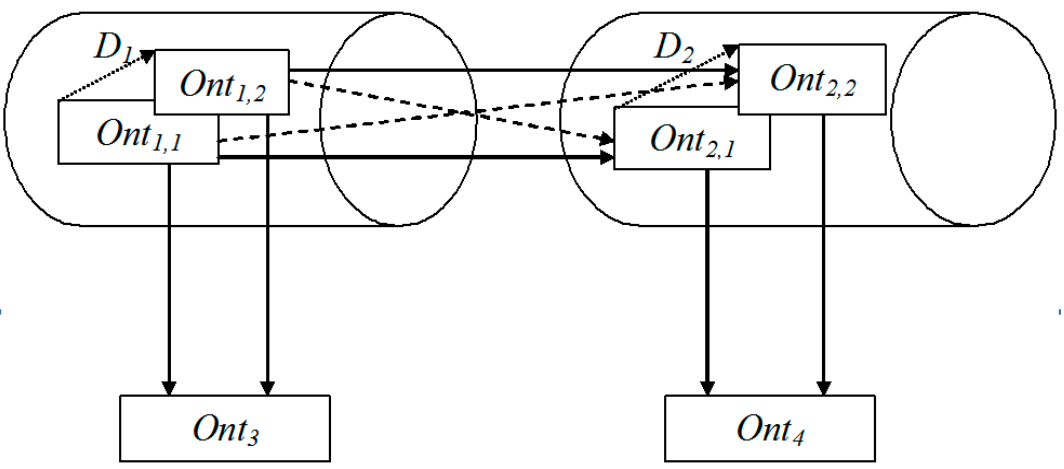
Figure 5. Scheme of the advanced hybrid development of ontology.